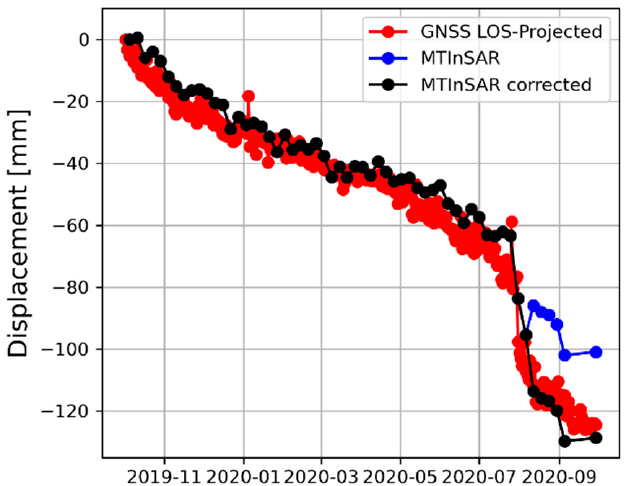
Figure 12. GNSS LOS-projected (red) and MTInSAR displacement time series for the PIES descending data. The phase unwrapping error in the original MTInSAR time series (blue) is corrected, yielding an error-free time series (black).